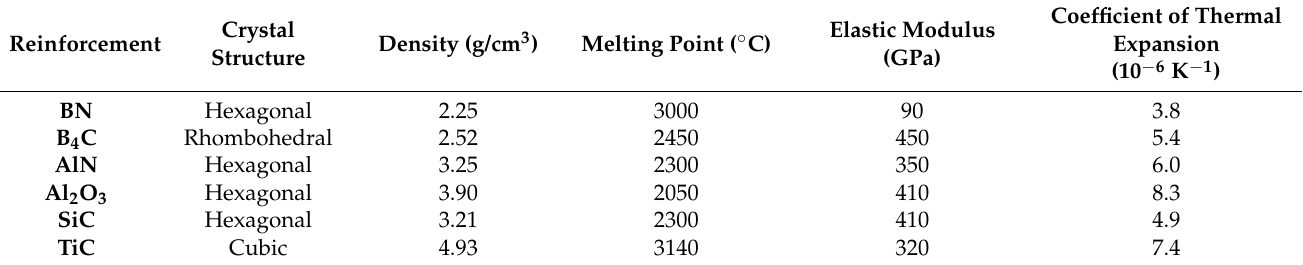
Table 2. Properties of particulate reinforcements